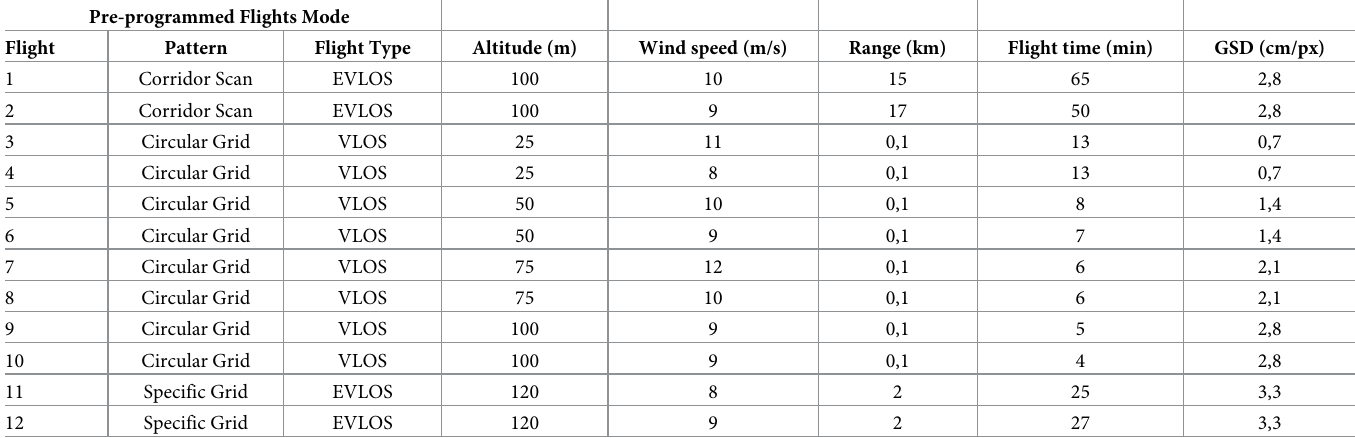
Table 1. Main pre-programmed flights